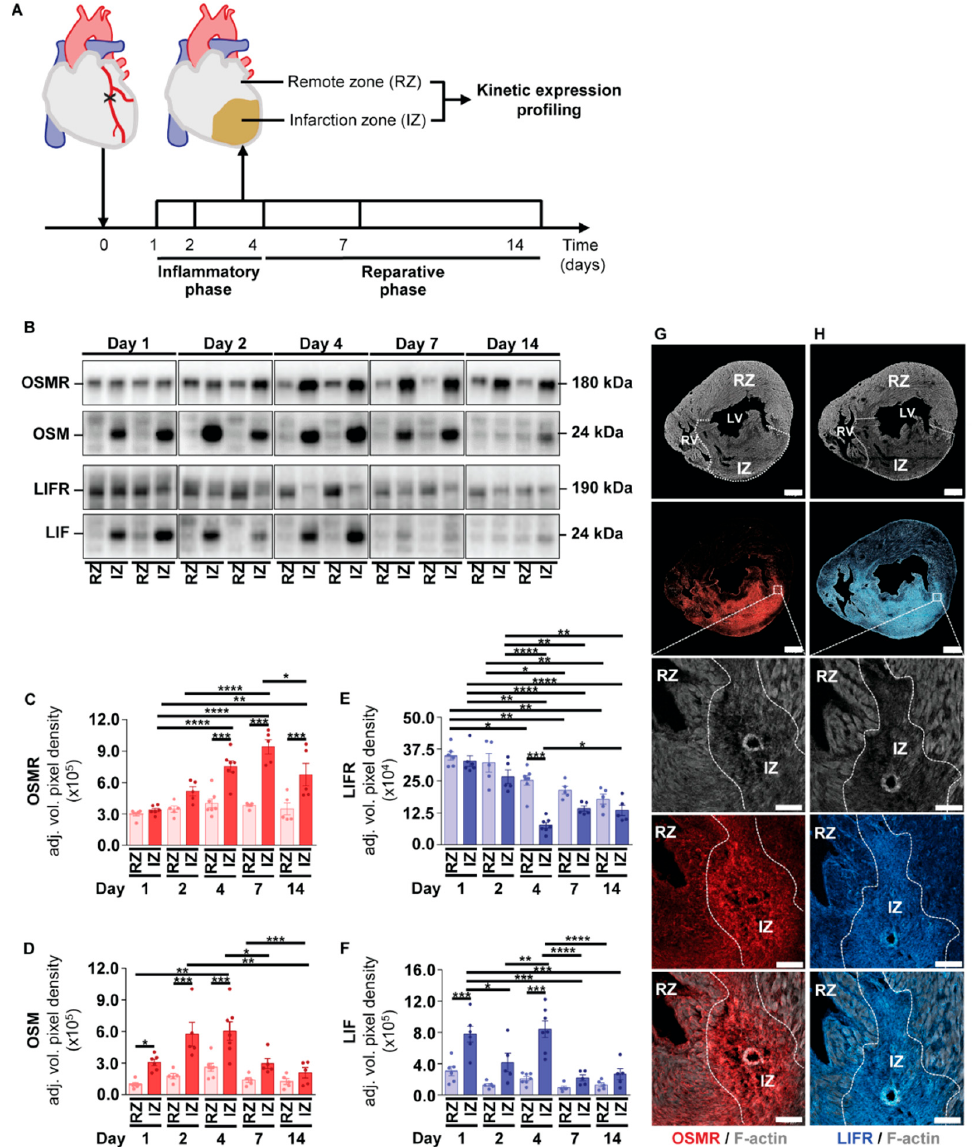
Figure 4. Kinetic expression pattern of OSM, LIF and their corresponding receptors OSMR and LIFR in cardiac tissue after the onset of myocardial infarction in mice. ( A ) Schematic illustration of kinetic expression profiling. Cardiac tissue was harvested at indicated time points post-MI and fractionated into a non-infarcted remote zone (RZ) and infarction zone (IZ). Expression of OSMR, OSM, LIFR and LIF in RZ and IZ was analyzed by immunoblotting (n = 6 at Day 1; n = 5 at Day 2; n = 7 at Day 4; n = 5 at Day 7; n = 5 at Day 14 post-MI). ( B ) Two representative immunoblots of OSMR, OSM, LIFR and LIF in RZ and IZ at indicated time points post-MI. ( C – F ) Semi-quantitative analysis of immunoblots shown in ( B ) based on the adjusted mean volume pixel density of bands. Statistical analysis was performed by two-way ANOVA. Asterisks indicate Bonferroni post-hoc test significances between RZ and IZ at individual time points as well as between RZ and IZ throughout the period of observation with * p < 0.05, ** p < 0.01, *** p < 0.001 and **** p < 0.0001. Data are presented as mean ± sem. Immunofluorescence analysis of ( G ) OSMR and ( H ) LIFR in infarcted hearts of mice 7 days after MI. F-actin: grey. OSMR: red. LIFR: blue. IZ: infarction zone. RZ: remote zone. RV: right ventricle. LV: left ventricle. Scale bars, 500 µm and 100 µm in magnified sections. We further studied the spatial expression profile of OSMR and LIFR in infarcted hearts of mice by immunohistochemical analysis. The overall expression pattern of both receptors was characterized by an intense staining of OSMR and LIFR within the infarcted